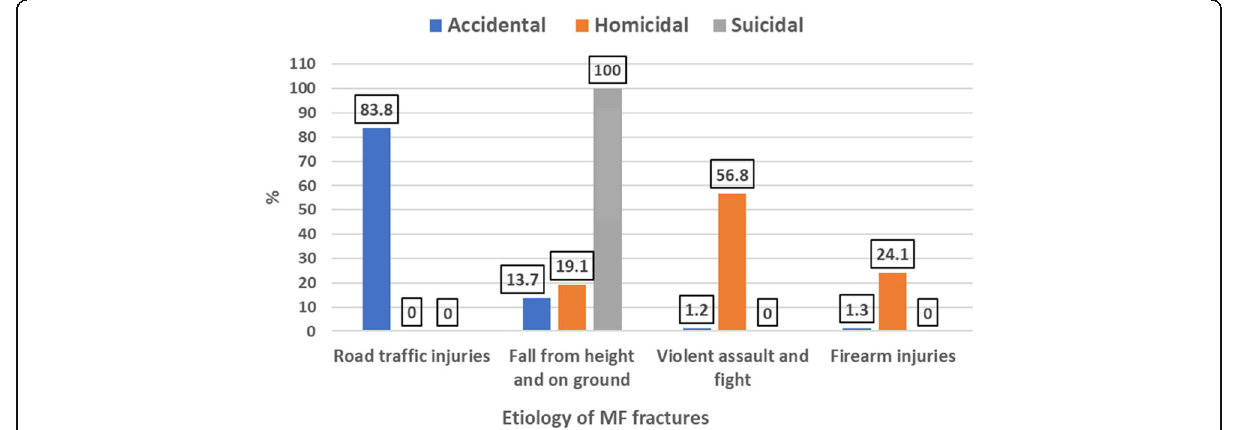
Fig. 4 Etiology of craniomaxillofacial fractures according to the manner of fracture infliction in the studied